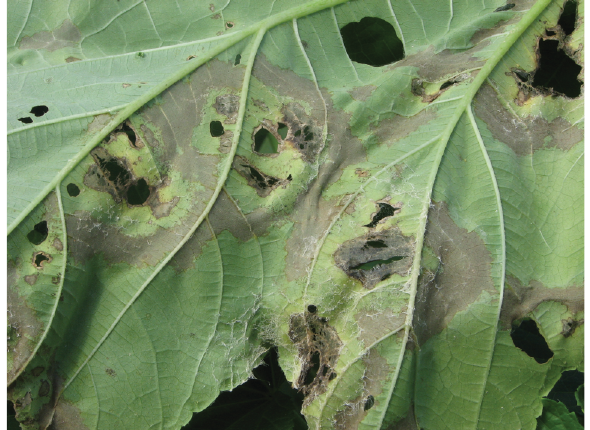
Figure 2. Abaxial surface of an okra leaf showing web blight symptoms and signs of the Thanatephorus cucumeris pathogen that is characterized by the growth of the pathogen’s